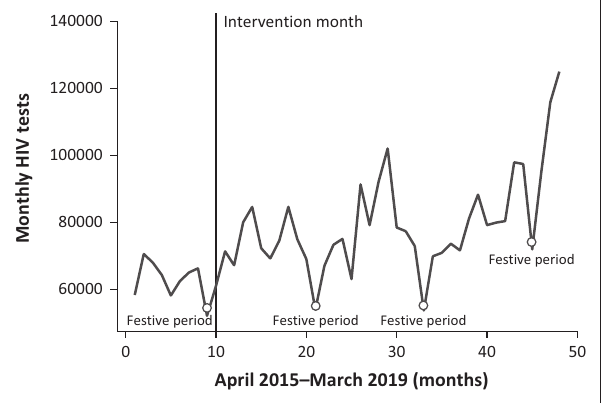
FIGURE 1: Overall average monthly increase or decrease in human immunodeficiency virus testing in the City of